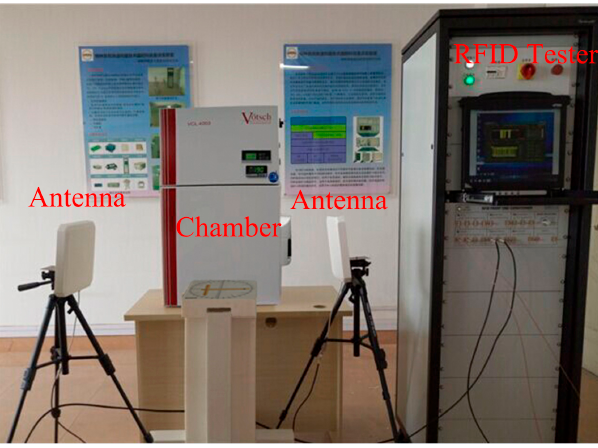
Figure 9. Wireless measurement environment.